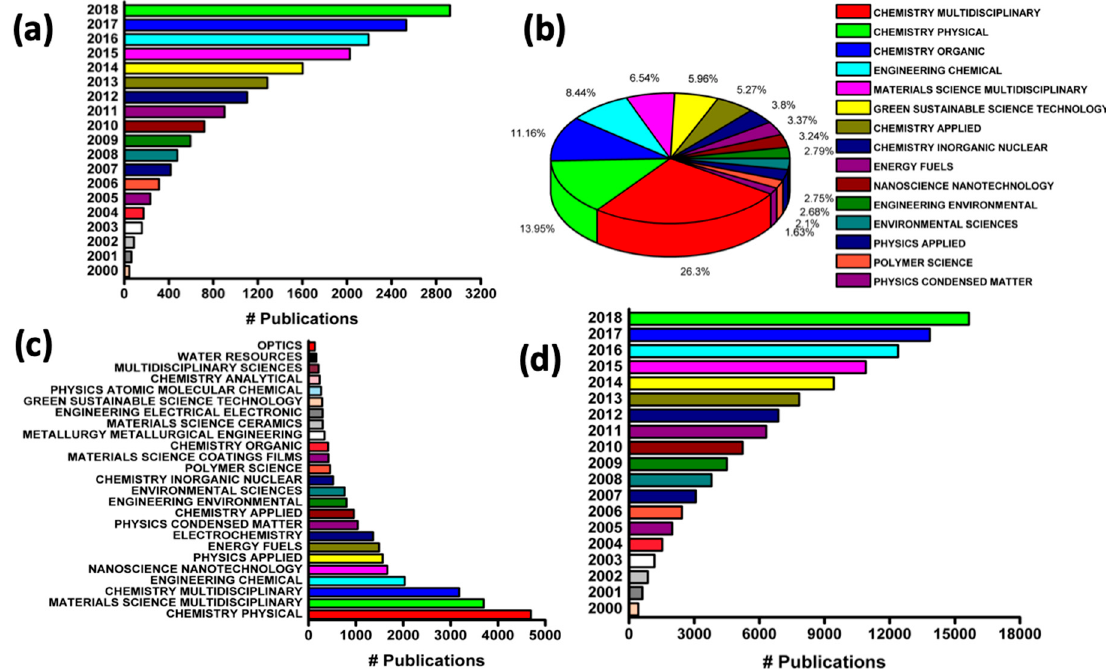
Figure 1. Statistics of publications between 2000 and 2018. ( a ) Approximate number of publications on green catalysts, ( b ) Approximate number of publications on metal nanoparticles, ( c ) Approximate number of publications on nanocatalysts, ( d ) Approximate percentage of publications on green catalysts. Source: Web of Science.